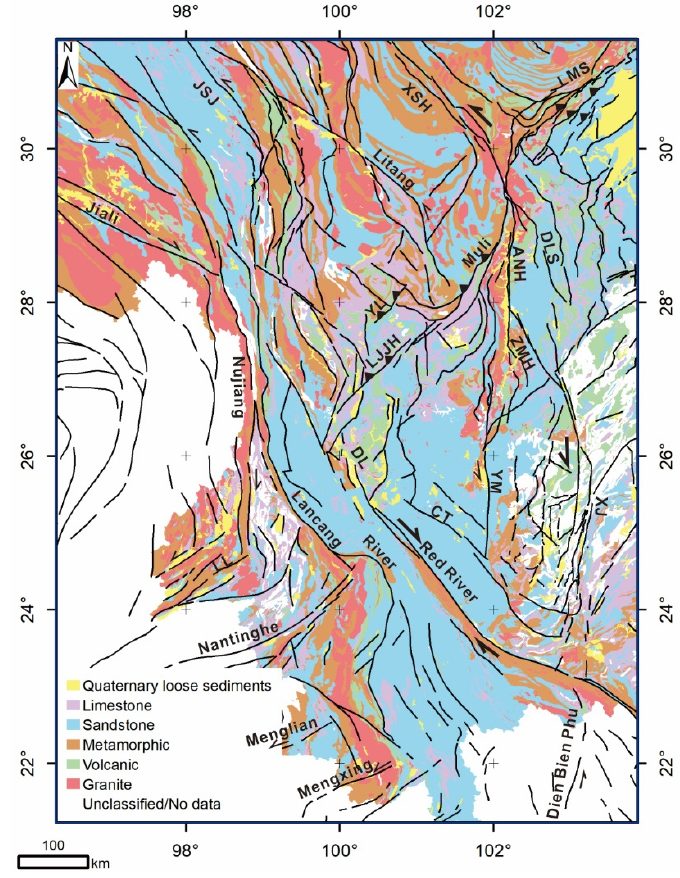
Figure 2. Lithological classification based on the regional 1:500,000 geological map, the rock prop- erties, and hardness levels (Table 1). Table 1. Description of classified lithological groups and of the Rock Strength Levels that increase from “Quaternary” to “Granite” 1 .